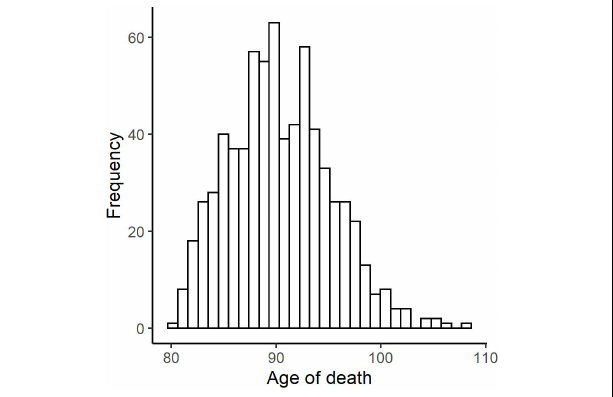
FIGURE 1 | Histogram of age of death in the OCTO-Twin